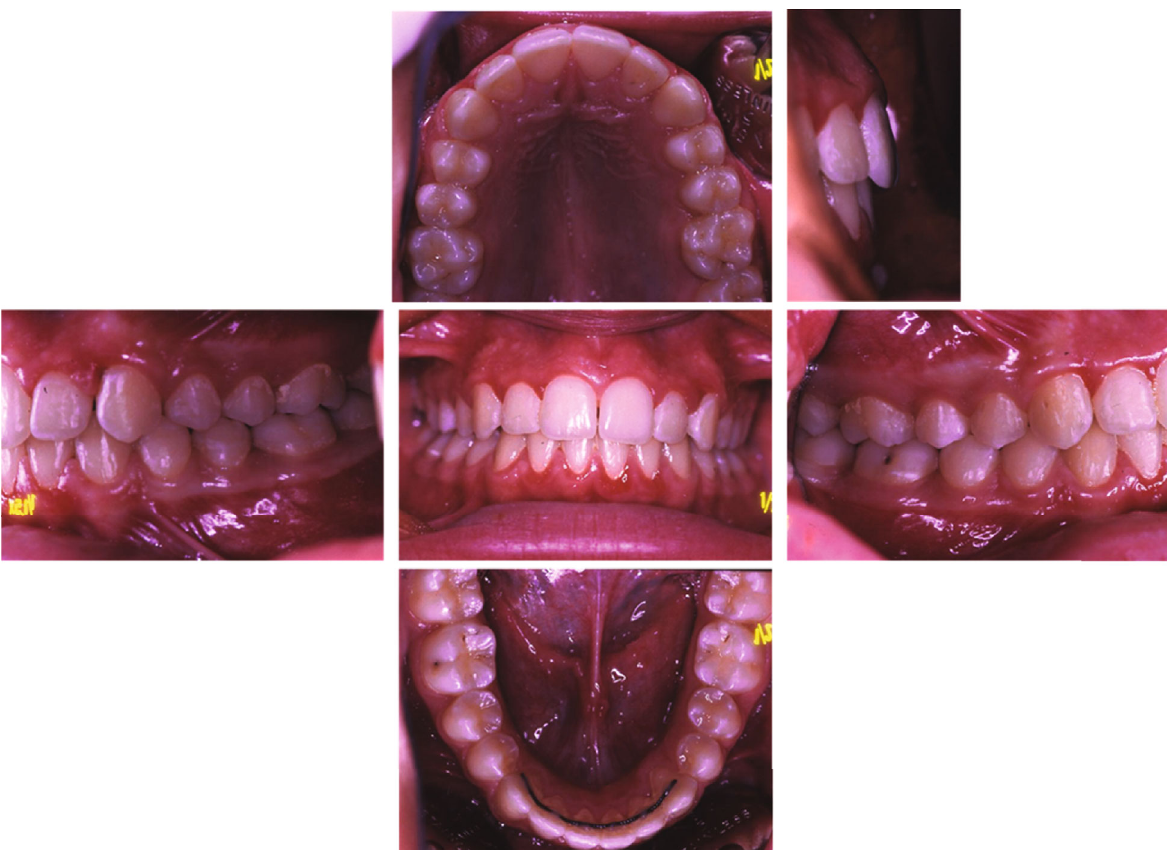
Figure 6: Final intraoral